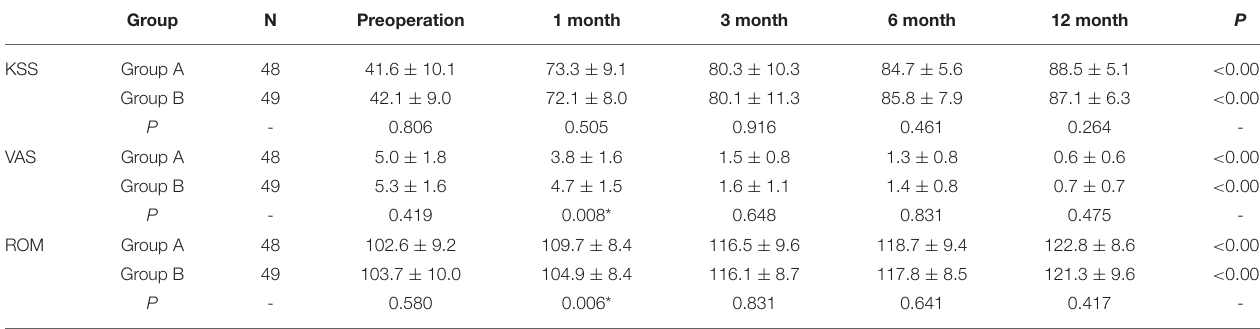
TABLE 5 | Comparison of postoperative KSS, VAS, ROM between the two groups. Group